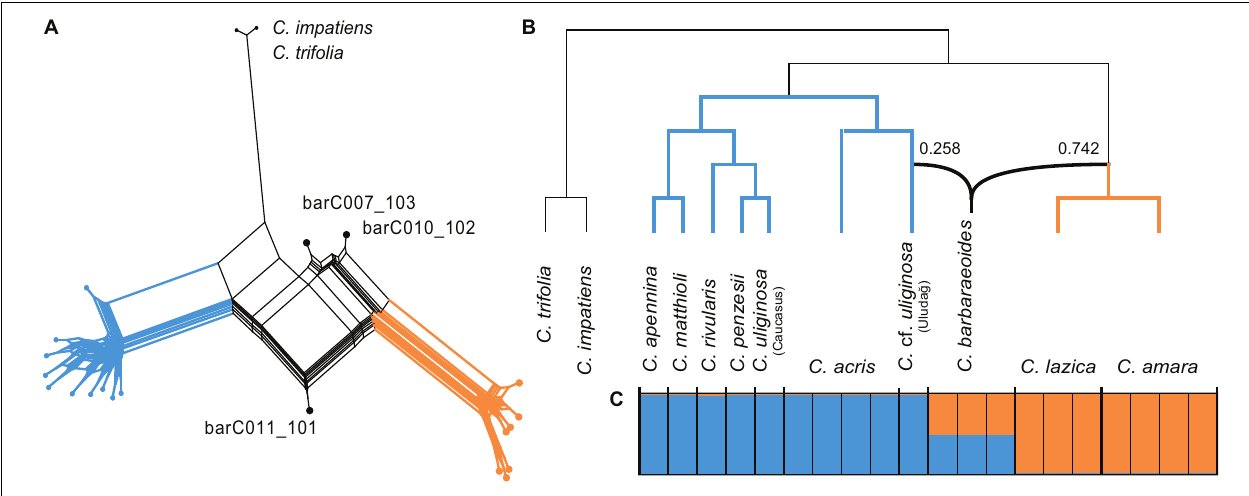
FIGURE 4 | Phylogenetic analyses indicating the hybrid (allopolyploid) origin of the tetraploid Cardamine barbaraeoides . Orange color is used for the accessions from the Cardamine amara group ( C. amara and Cardamine lazica ), blue for the remaining diploids, and black for the tetraploid C. barbaraeoides . (A) Supernetwork representation of quartets generated in SuperQ, which was derived from 1,168 nuclear gene trees estimated in RAxML and based on consensus supercontig sequences. (B) Species network inferred in PhyloNet from the same set of 1,168 nuclear gene trees. Inheritance probabilities are shown along the branches indicating the origin of C. barbaraeoides . (C) Bayesian clustering of SNP datasets in STRUCTURE at optimal K = 2, obtained from variant calling in a selection of 947 most informative genes. The coloring in the graph indicates the sample assignment to the two genetic clusters. Thick vertical lines separate different